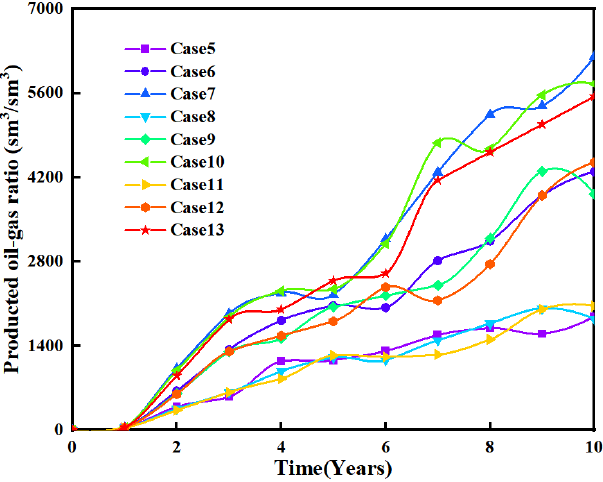
Figure 12. Production gas – oil ratio curves of each scheme.